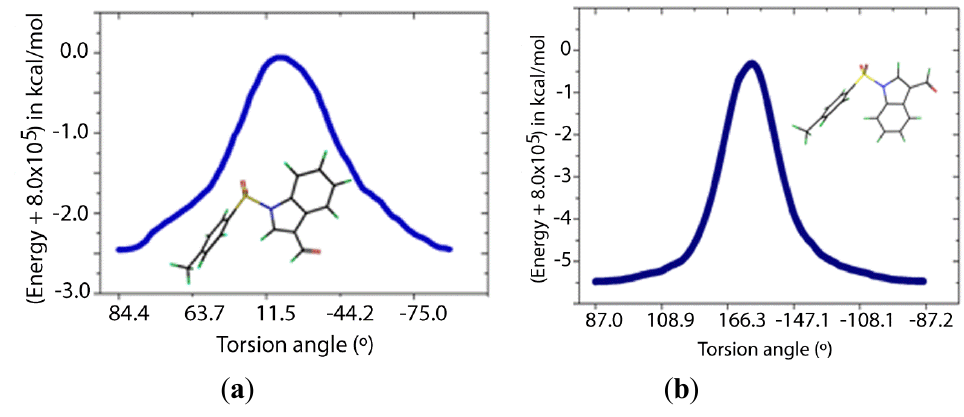
Figure 8. IRC of the rotational barrier about the S-N bond in 1 : ( a ) 1TS1 and ( b ) 1TS2 . Insets are the corresponding molecular structures Torsion angle (°) (Energy + 8.0 × 10 5 ) in kcal/mol.